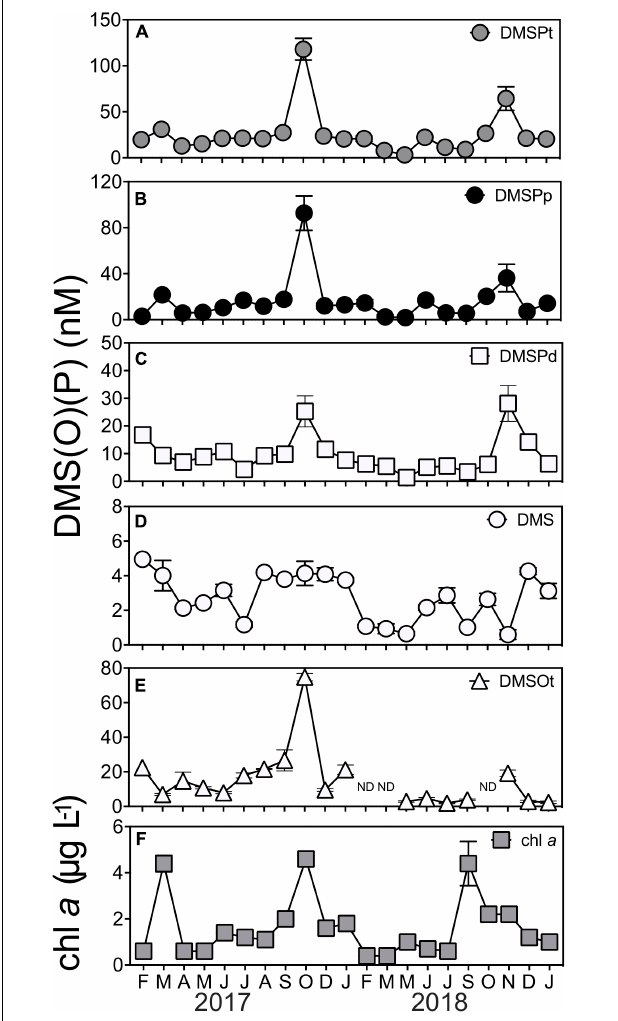
FIGURE 1 | Concentrations of marine sulfur compounds (A) total DMSP (DMSPt) (B) particulate DMSP (DMSPp), (C) dissolved DMSP (DMSPd), (D) dimethyl sulfide (DMS), (E) total DMSO (DMSOt), and (F) chlorophyll a (chl a ) at Port Hacking NRS between February 2017 and January 2019. DMS (P) data are means ± standard error ( n = 3). ND, non-detected, indicating concentrations were below the detection limit of 1 pmol.